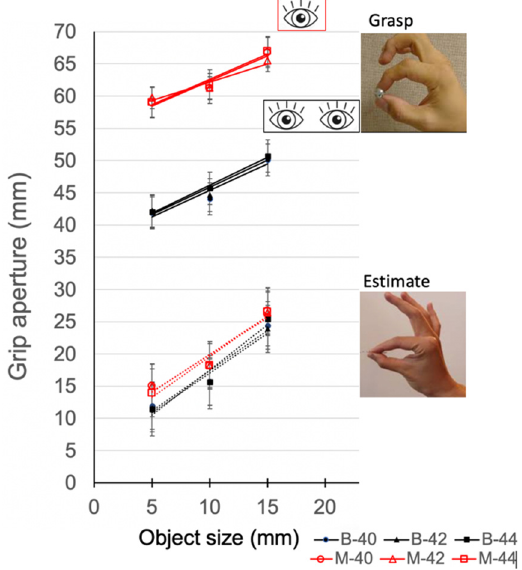
Figure 2. Mean grip aperture plotted for the grasping task (solid lines) and estimation task (dashed lines). Error bars show ±1 standard error. B: binocular (depicted by black symbols); M: monocular (depicted by red symbols); B40/M40 objects presented at 40 cm; B42/M42: objects presented at 42 cm; B44/M44: objects presented at 44 cm.